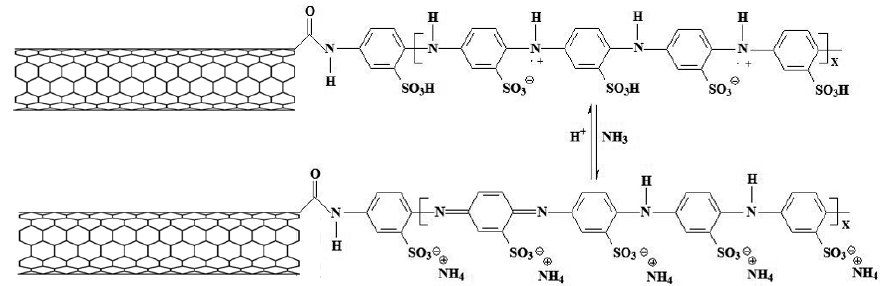
Figure 5. Interaction of SWNT-PABS with NH 3 . Adapted from Reference [53].